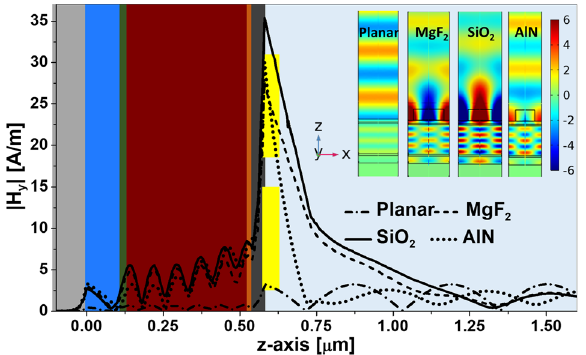
Figure 4. A line plot for the magnetic field y-component through the whole device without the bow-tie (black line) and with the bow-tie made of MgF 2 (green line), SiO 2 (red line), and AlN (blue line). The magnetic field inside the active layer is greatly enhanced due to the excitation of SPRs when including the bow-ties. The inset is for the magnetic field distribution y-component H y in the xy plane at (cid:31) = 632.8 nm for the planar structure (no resonant elements) and the case of the bow-ties fabricated with the three selected